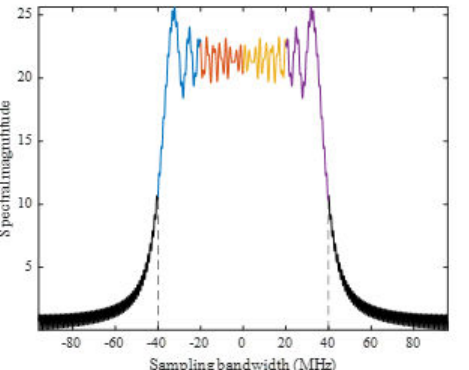
Figure 2. Demonstration of frequency diversity-based sub-band